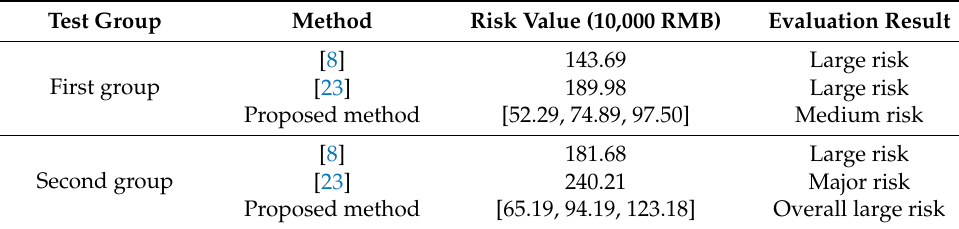
Table 11. Comparison of the evaluation results.